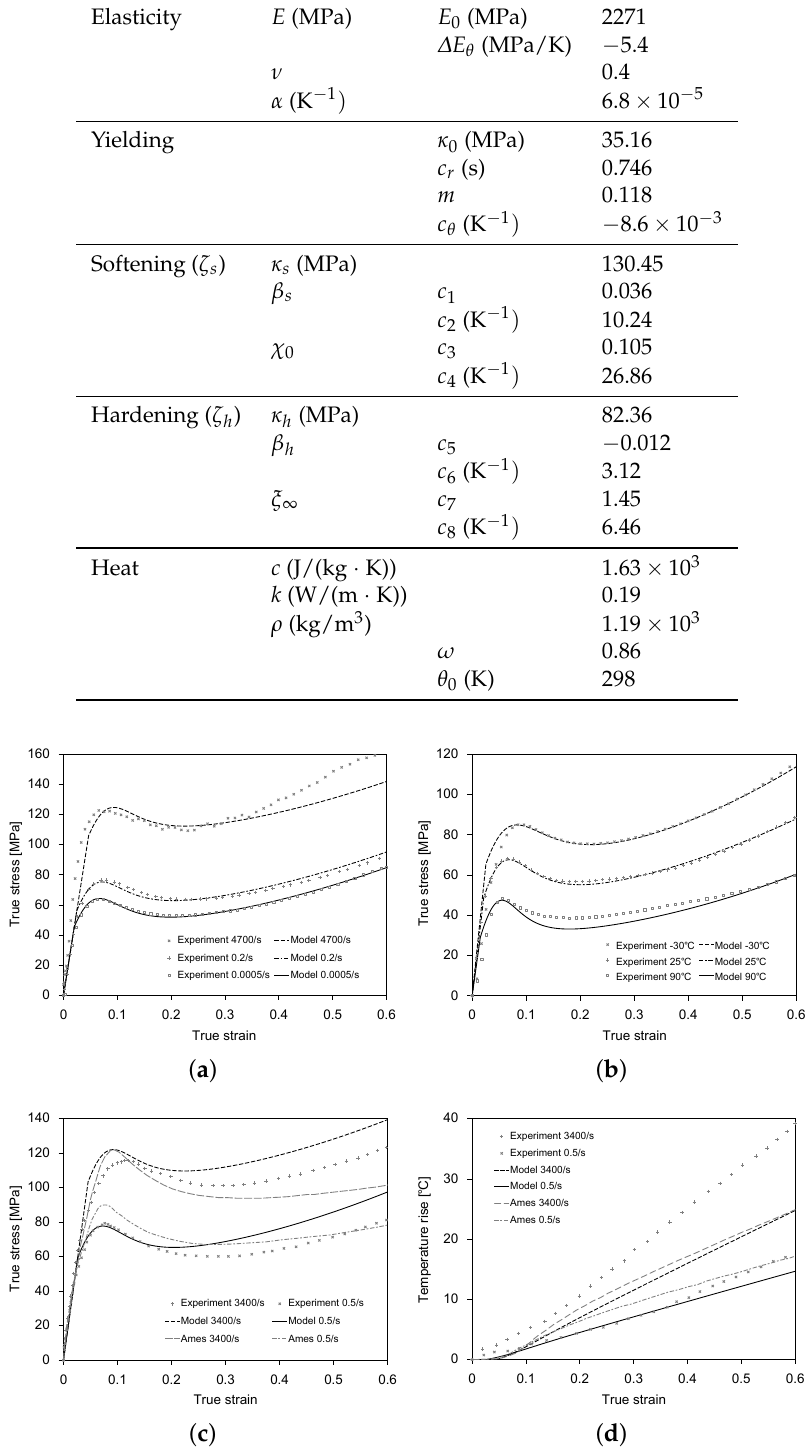
Figure 2. Model validations against the experimental data: ( a ) stress-strain curves at different strain rates; ( b ) stress-strain curves at different temperatures; ( c ) stress-strain curves and ( d ) temperature rises compared to the experimental data of [35] and simulation results of